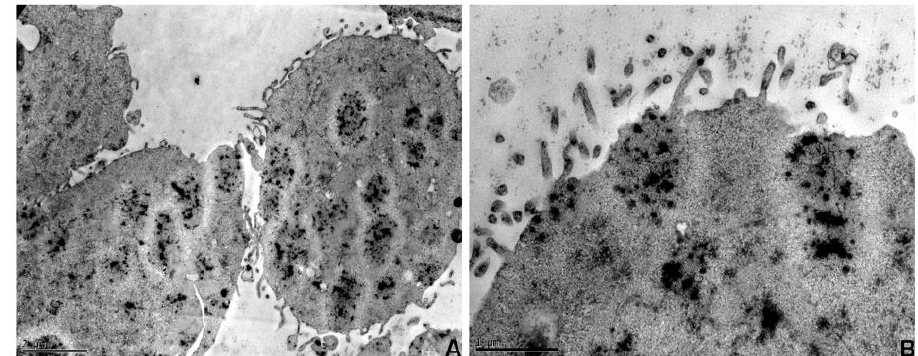
Figure 2. Ultrastructural aspects of UM-HMC-3A. ( A ) Epithelial cells derived from mucoepidermoid carcinoma. Note the electron dense granules in cytoplasmic vacuoles; ( B ) Mucoepidermoid carcinoma epithelial cells in culture with adhesion specializations in the cell membrane. Scale bars: A, 2 µm; B, 1 µm.